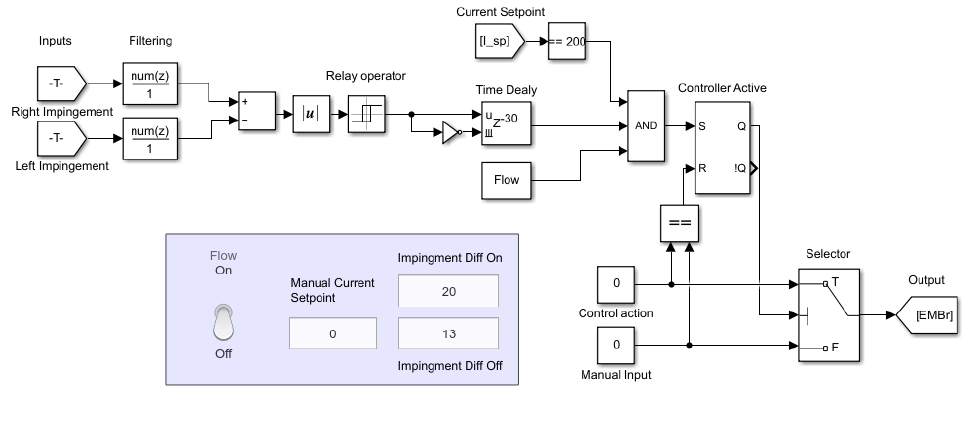
Figure 7. Real-Time SIMULINK implementation of the controller. The controller evaluates the difference of the jet impingement points on both sides. If the difference is within a window defined by the relay operator for 15 s, the controller will set a new EMBr current if the experiment is in operation, and EMBr current is at a valid set-point. Controller is reset and ready for new evaluation when the operator set a manual current set-point to be equal the controller value.